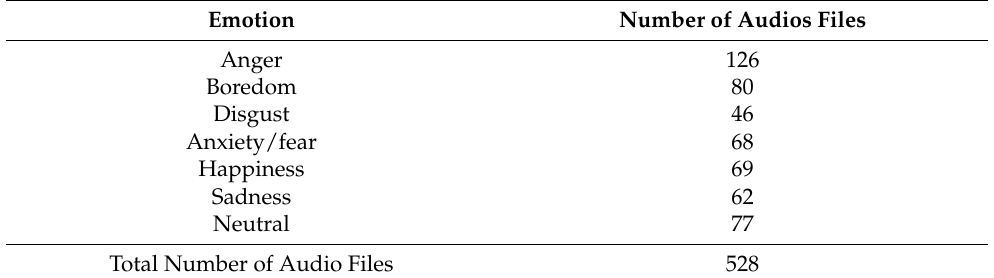
Table 1. Emotion distribution of the edited Berlin Database